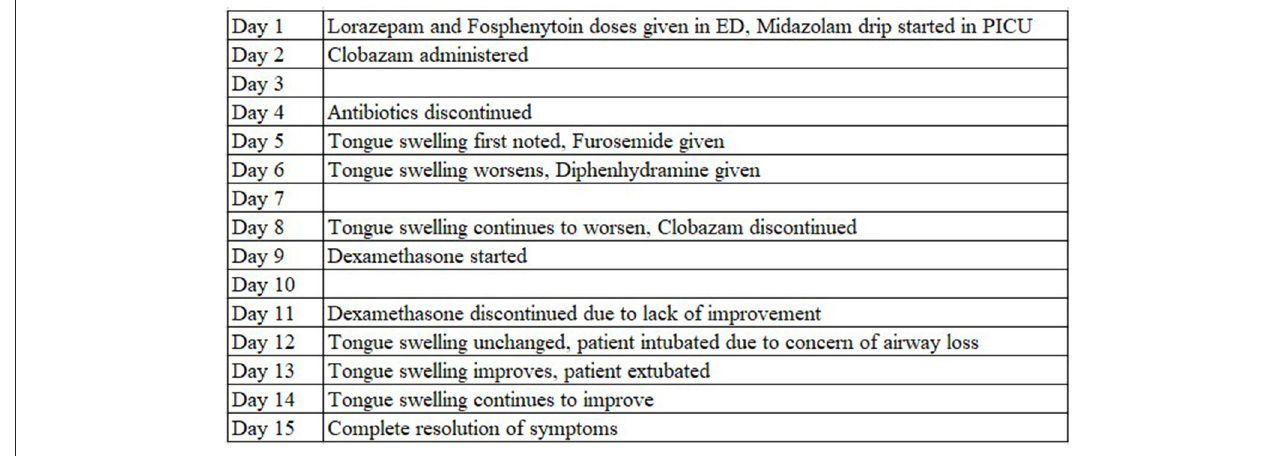
FIGURE 1 | Timeline of patient hospitalization events.